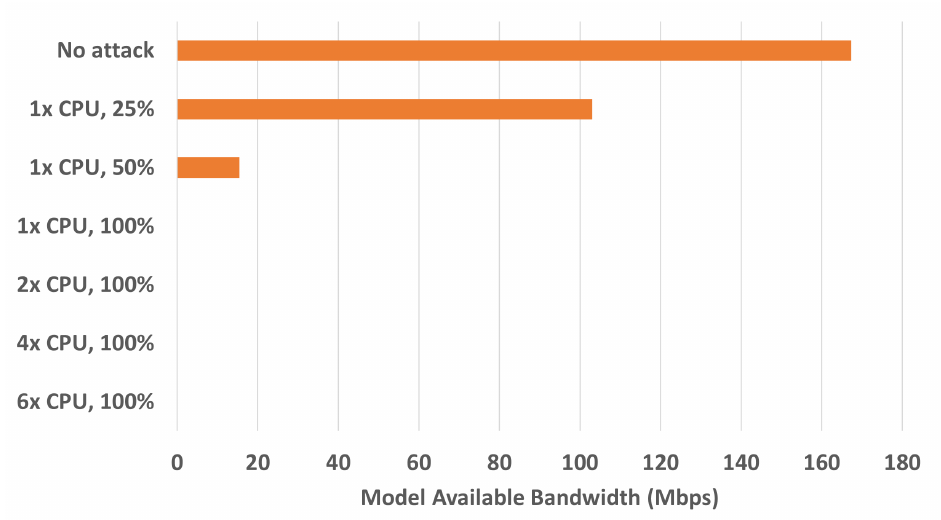
Figure 8. Effects of the attacker’s performance on the simulation